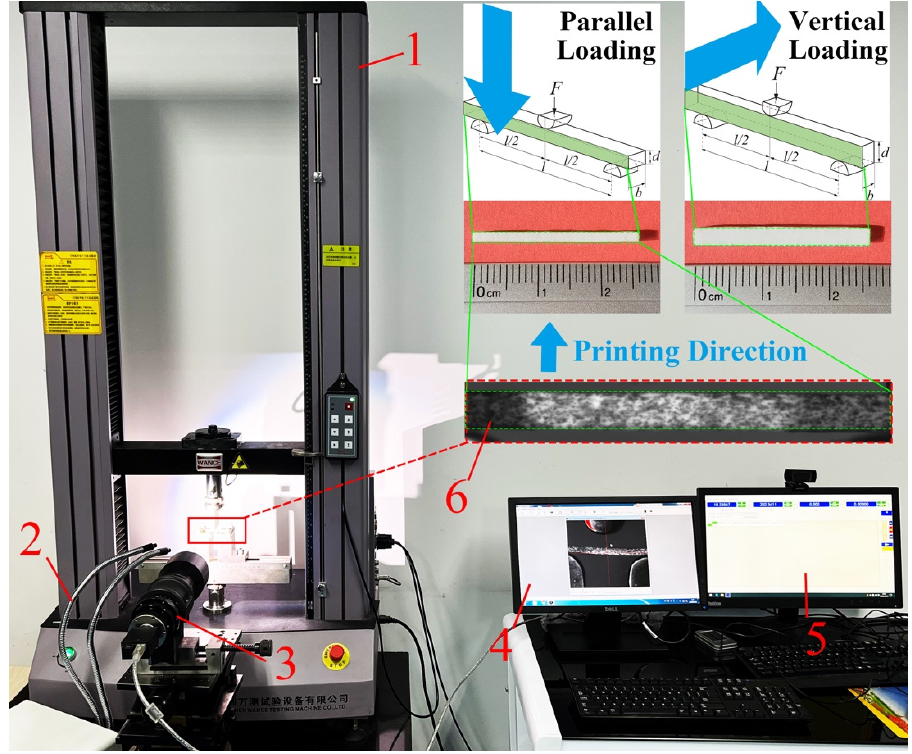
Figure 4. Three-point bending test facility (1—universal testing machine, 2—light source, 3—DIC camera, 4—DIC camera data acquisition, 5—testing machine data acquisition, 6—specimen).